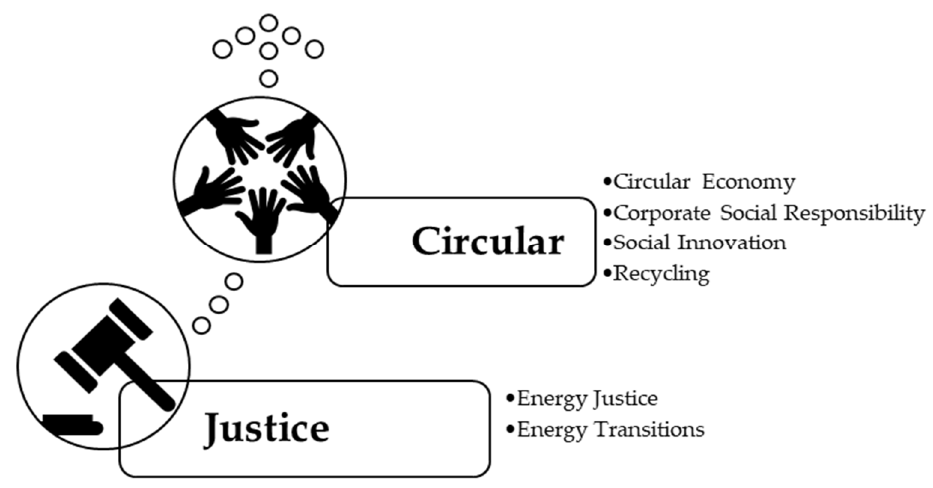
Figure 17. Main topics of Justice–Circular Clusters.